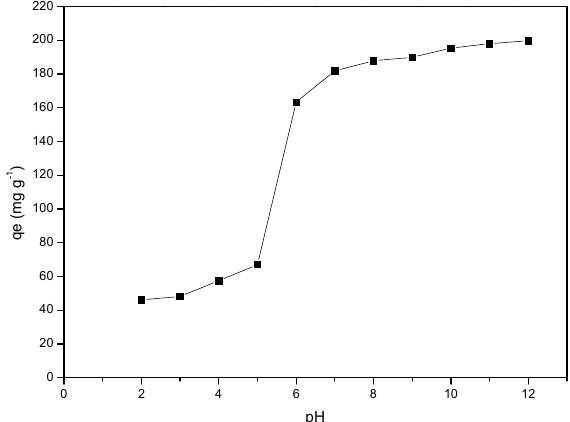
Figure 4. Effect of pH on the adsorption of MB dye by RF/TiO 2 gel.